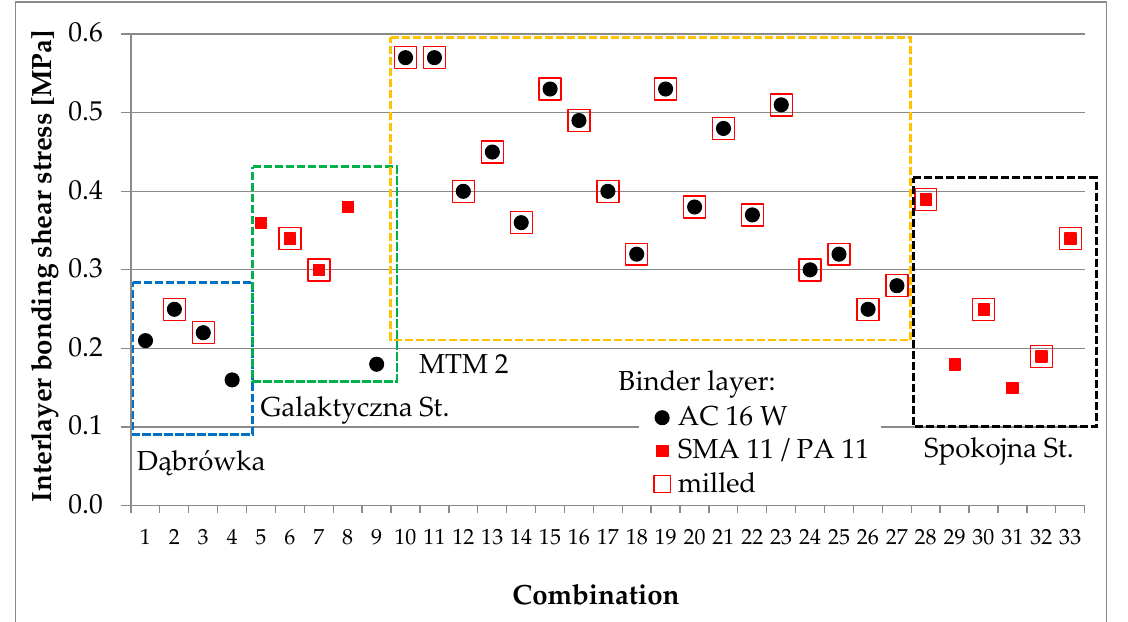
Figure 15. Summary of interlayer bonding shear stress results for samples from test sections.